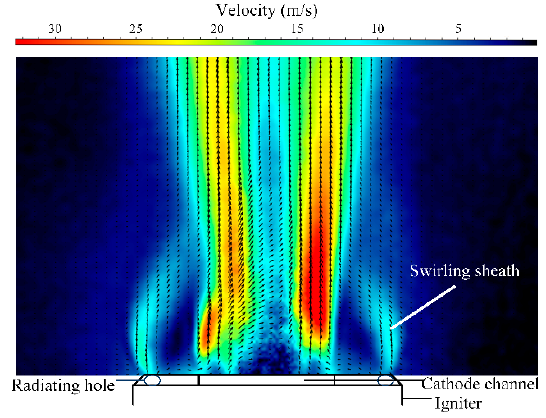
Figure 9. Igniter outlet flow field at ∆ p = 350 Torr.